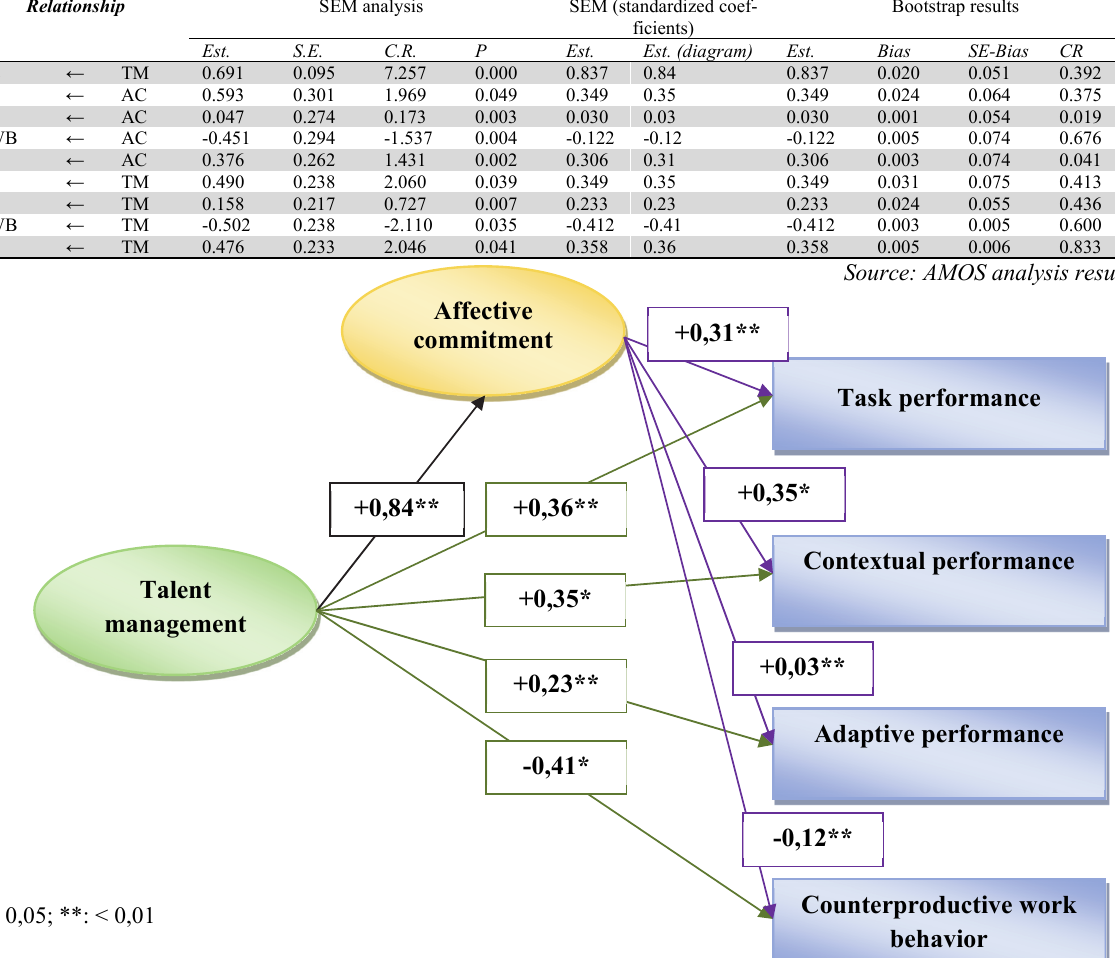
Fig . 3 . Linear SEM analysis results reflecting the relationship between talent management and employees’ performance in